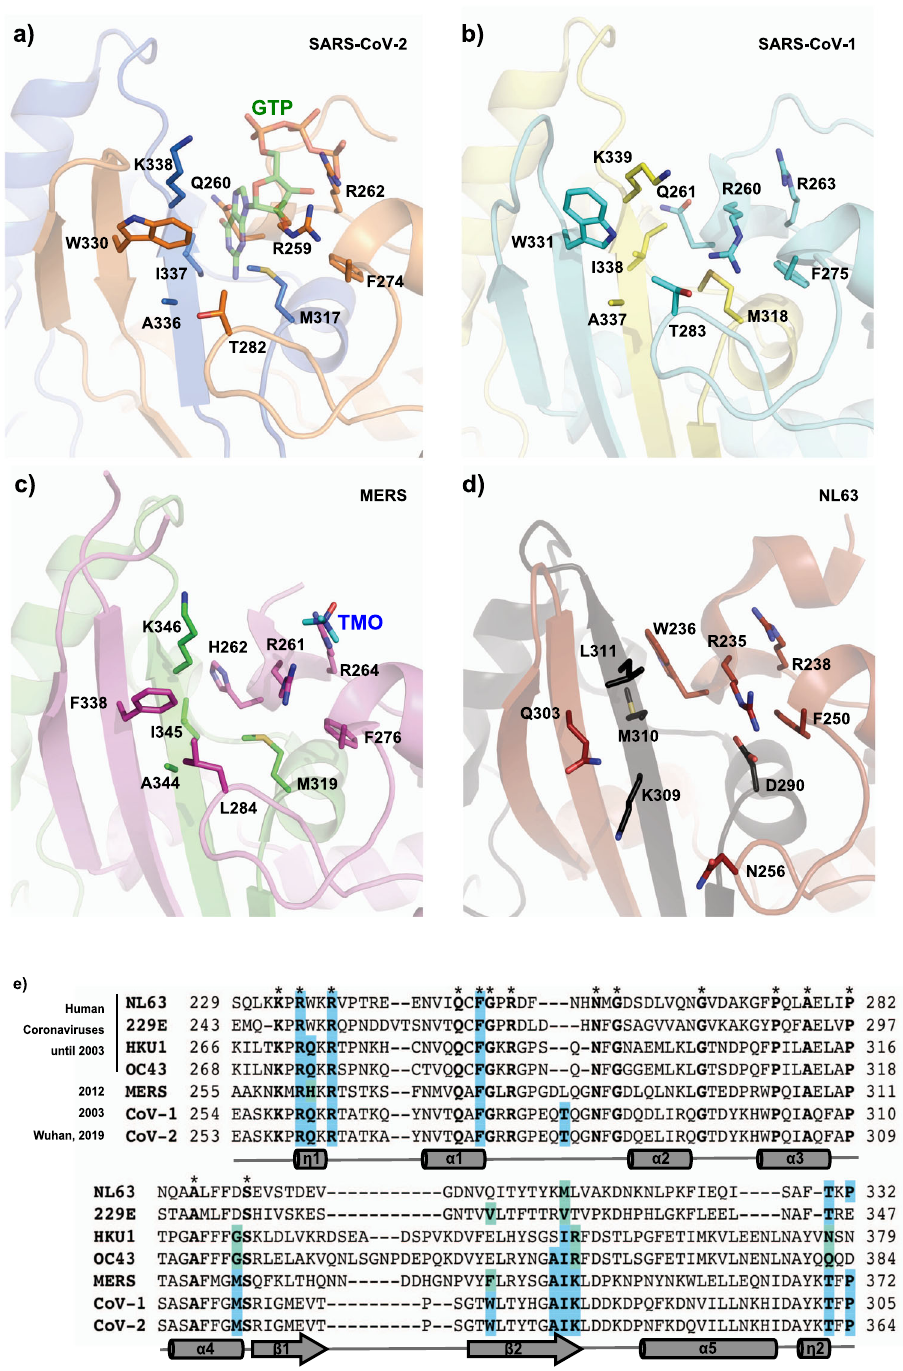
Fig. 5 Conservation of the Guanine binding pocket in human coronaviruses. Cartoon representation of the GTP binding pocket in SARS-CoV-2 ( a ), SARS- CoV-1 (PDB 2GIB) ( b ), MERS (PDB 6G13) ( c ) and NL63 (PDB 5EPW) ( d ). Each monomer of the dimer is represented in different colors. The residues that mediate the GTP binding in SARS-CoV-2 and equivalent residues in other coronaviruses are shown in sticks with carbons in the same color as the monomer to which they belong. The GTP molecule is represented in semi-transparent sticks with carbon atoms in green. The trimethylamine oxide (TMO) bound to MERS is shown in sticks with carbons in cyan. e Sequence alignment of N CTD of human coronaviruses. Invariant residues are in bold and indicated with an asterisk above the sequence. Residues for the GTP binding are in bold and highlighted in blue, and conservative changes are in light green. Secondary structural elements of the SARS-CoV-2 N CTD are represented below the sequence and labeled and numbered from N to C. η corresponds to 3 10 helices; α to α -helices and β to β